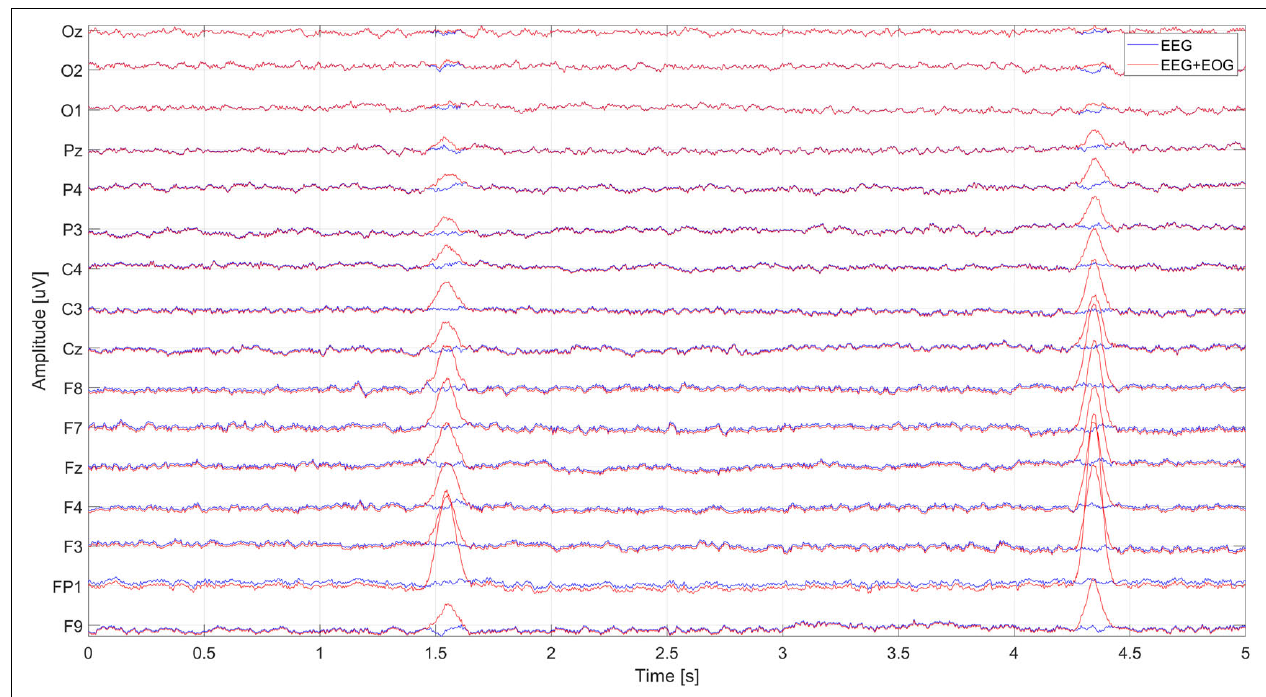
FIGURE 6 | Artificially generated EEG and EEG + EOG